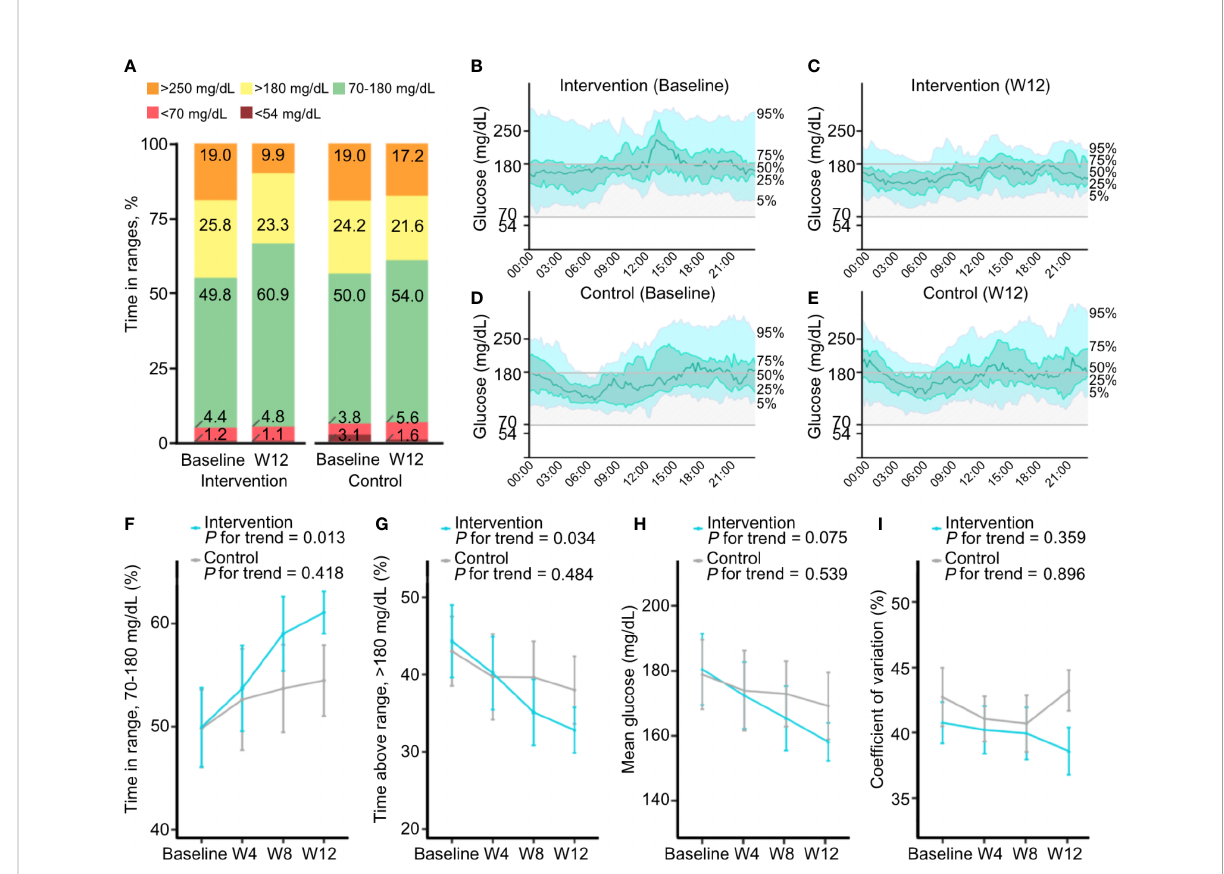
FIGURE 2 Changes in continuous glucose monitoring metrics during the study. (A) Mean percentages of time with glucose in ranges of <54, <70, 70 – 180, >180, and >250 mg/dL at baseline and week 12 in the intervention and control groups. (B – E) Ambulatory glucose pro fi les, which are summaries of glucose values from 14 consecutive days at baseline and at week 12, in the intervention group (B, C) and the control group (D, E) . The median line (green line) is surrounded by the interquartile range (25th to 75th percentile, shaded in light green) and the interdecile range (10th to 90th percentile, shaded in light blue). (F – I) Changes in continuous glucose monitoring metrics at 4-week intervals. Mean percentages of time with glucose in ranges of 70 – 180 (F) and >180 mg/dL (G) , mean glucose (H) , and coef fi cient of variation (I) at baseline and at weeks 4, 8, and 12 in the intervention and control groups. Data are presented as the mean ±